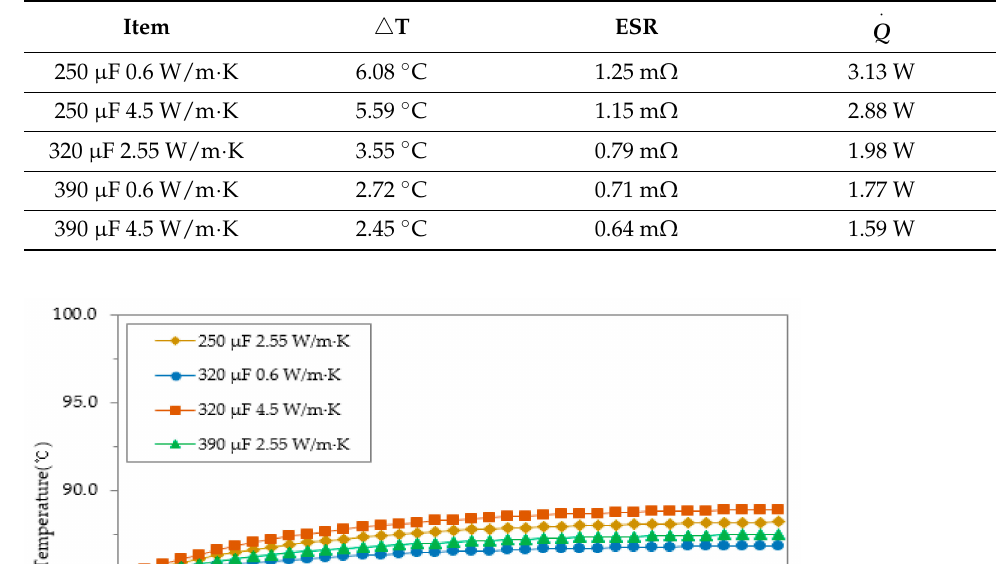
Figure 4. FEA results of capacitance and thermal conductivity epoxy for film thickness of 3.15 µ m. Table 5. Analysis results of film thickness of 3.15 µ m.